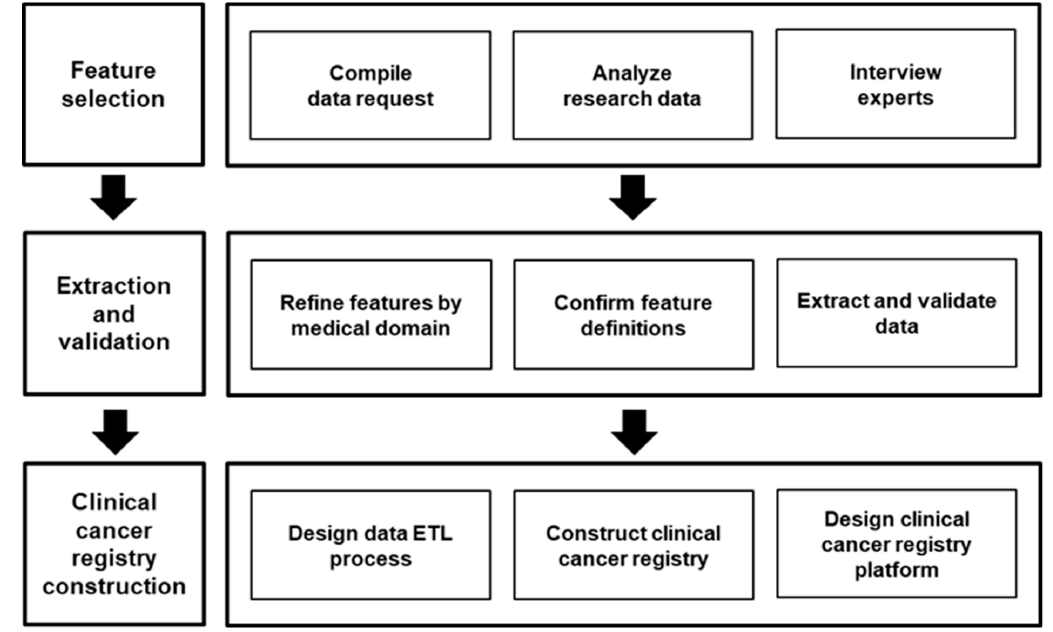
Figure 2. Clinical cancer registry construction and utilization process. ETL, extract, transform, and load.